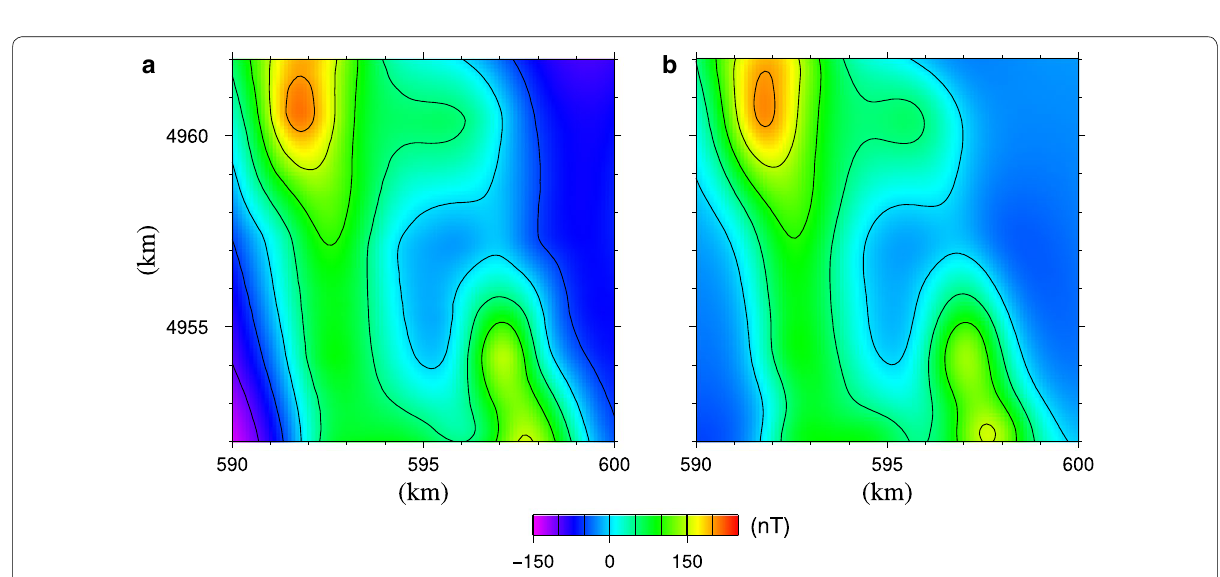
Fig. 21 a The magnetic anomaly in the area of Figure 14 from which the linear trend has been removed. The original data are a portion of the Aeromagnetic Anomalies Database of Japan (Nakatsuka and Okuma, 2005). b The magnetic anomaly recovered by the optimal model in Fig. 23. The coordinate system of these figures is UTM, and the color scale indicates the magnetic anomaly in